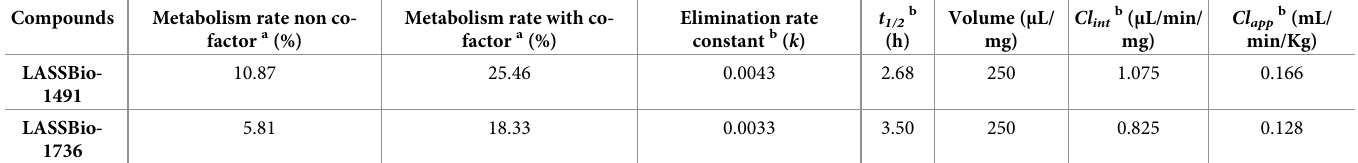
a Co-factor: NADPH regenerating system; Animal weights: 385,0 g; Liver weights: 12,0 g; Microsomal protein: 59,77 mg/mL. b Calculations performed for the assay with co-factor Cl intrinsic ( μ L/min/mg) = Volume x (0,693/t 1/2 ) Cl apparent (mL/min/mg) = (0.693/t 1/2 min) x (incubation volume mL/microsomal protein mg) x (microsomal protein mg/liver g) x (liver g/rat weight